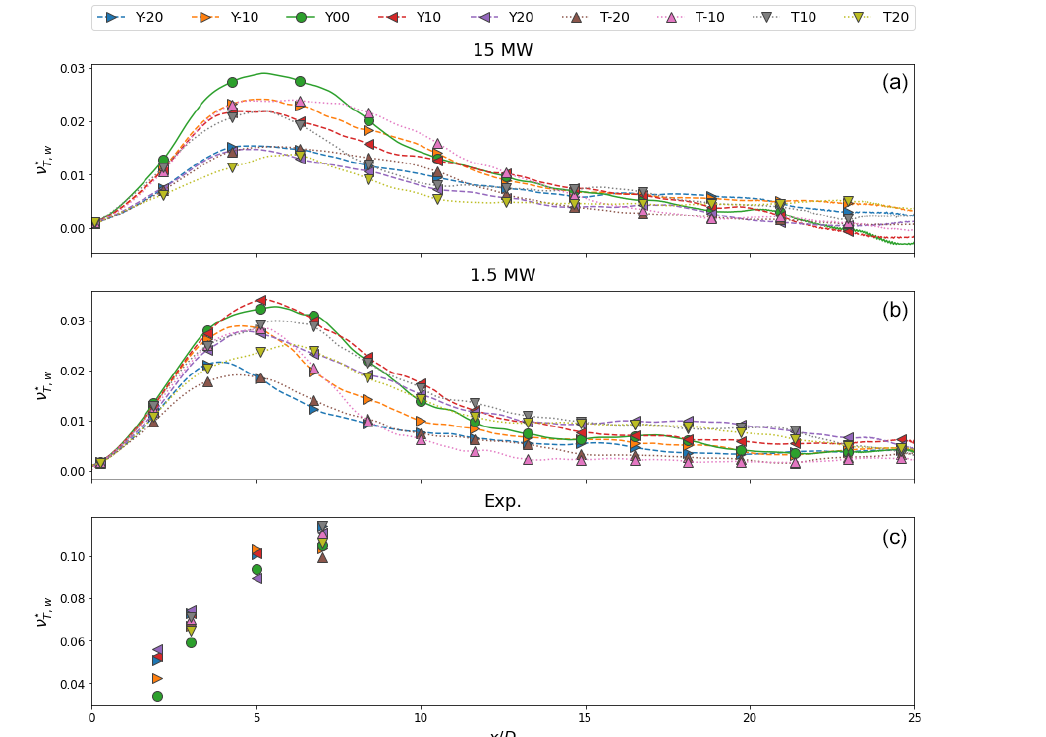
Figure 7. Scaled streamwise wake eddy viscosities for 15MW (a) , 1.5MW (b) , and scaled model turbine (c) cases. Nacelle misalignment reduces peak eddy viscosity by modifying wake recovery. Large misalignment angles produce weak wakes with strong counter-rotating vortex pairs and low-peak eddy viscosities. Note that experimental data are only available to 7 D downstream and yawed cases contain two measurements at x/D = 3 and x/D =